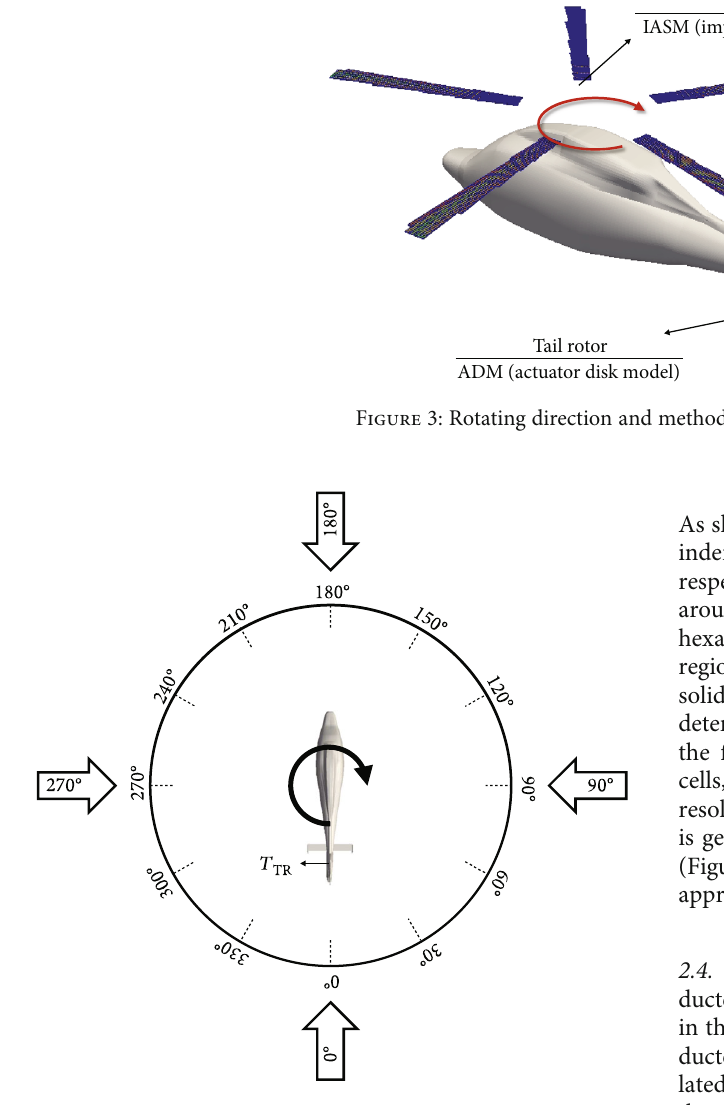
Figure 4: Crosswind directions